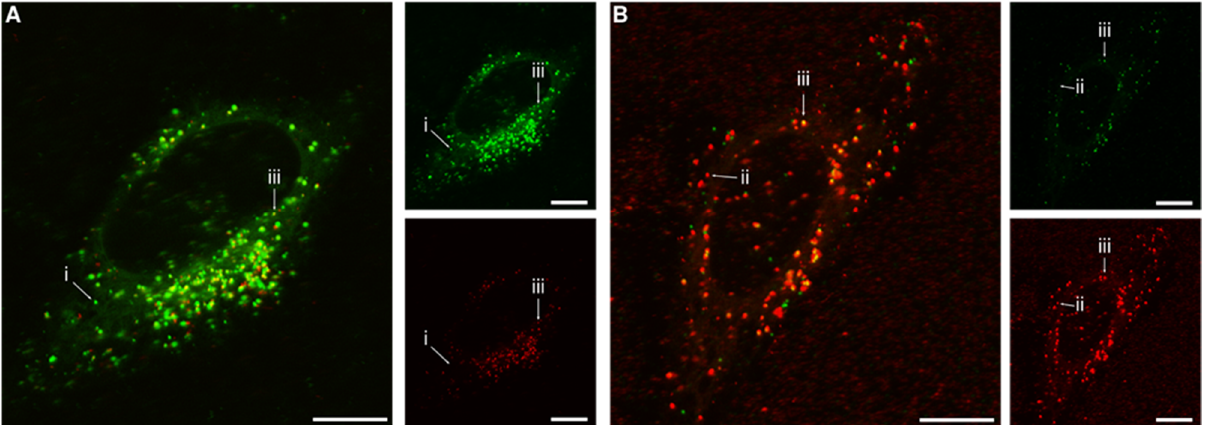
Figure 5. Subcellular distribution of the 40 nm and 100 nm particles. Cells were exposed for 24 h to both the 40 nm and 100 nm particles simultaneously and then observed using confocal fluorescence microscopy. ( A ) Concentration of 100 and 40 nm particles 20 and 100 µg/mL, respectively (0.060 nM and 4.7 nM; conditions correspond to the highest 40 nm particle concentration in Figure 2 and Figure S3). ( B ) Concentration of 40 and 100 nm particles 6.25 and 80 µg/mL, respectively (0.30 and 0.24 nM; conditions correspond to the highest 100 nm particle concentration in Figure 4 and Figure S4). The larger images show overlaps of both fluorescence colours, while the smaller images show the individual colours. (Green) 40 nm particles; (red) 100 nm particles. Arrows show examples of (i) 40 nm particle(s) (green) in the absence of 100 nm particles; (ii) 100 nm particle(s) (red) in the absence of 40 nm particles; (iii) 40 and 100 nm particles in the same location. The results show that the two particles often end up in the same location, but not always. All scale bars correspond to 10 µm.